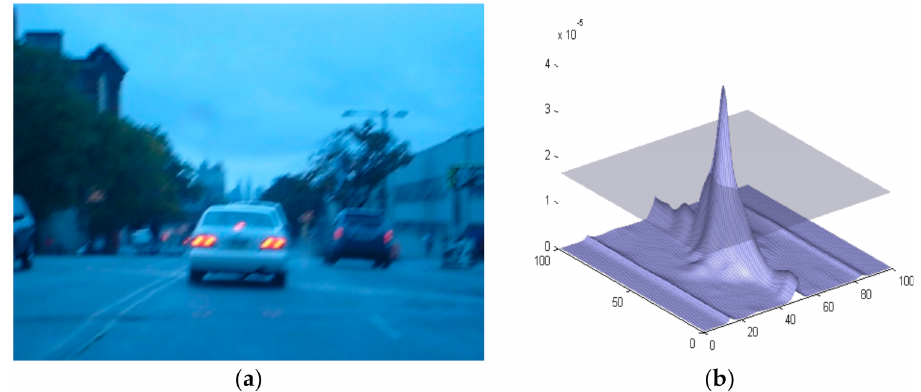
Figure 3. ( a ) A sample image of Blur Car (Data Set-1) and ( b ) MACH results.